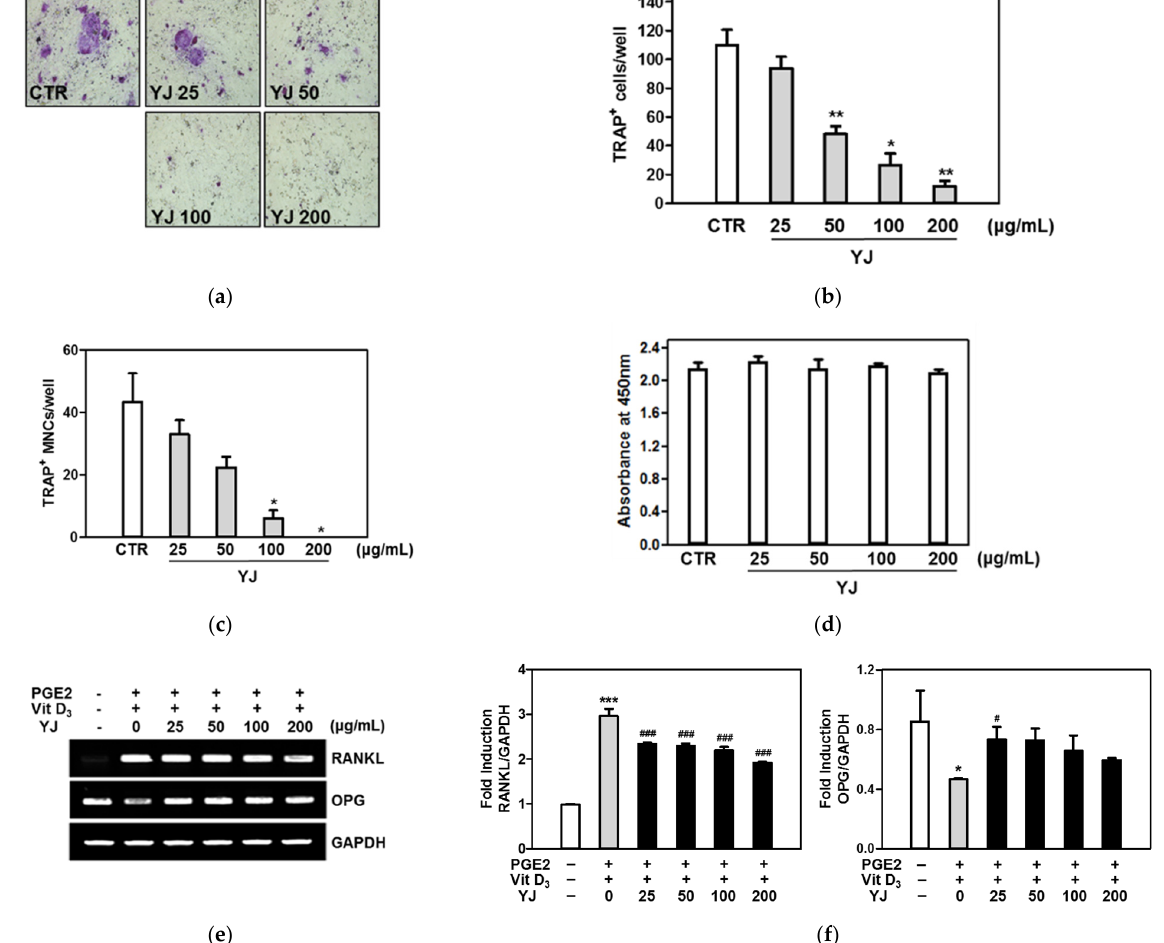
Figure 2. YJ suppressed osteoclastogenesis in the co-culture of bone marrow cells (BMCs) and mouse calvaria-derived osteoblasts. ( a ) BMCs and mouse calvaria-derived osteoblasts were co-cultured for 7 days in a medium containing vit D 3 and PGE2 in the presence of YJ. Cells were fixed, permeabilized, and stained with TRAP solution. Images were captured under a light microscope (100× magnification). ( b , c ) TRAP-positive cells and TRAP-positive MNCs with more than three nuclei were counted. ( d ) Co-cultured cells were seeded into a 96-well plate and cultured for 4 days. After 4 days, cell viability was analyzed using the XTT assay. ( e ) Total RNA was extracted from the cells, and the mRNA levels of OPG, RANKL, and GAPDH (glyceraldehyde 3-phosphate dehydrogenase) were measured using RT-PCR. For RT-PCR analysis, the PCR products were electrophoresed on a 1.5% agarose gel and were visualized by ethidium bromide staining. ( f ) Quantitative real-time RT-PCR was performed to determine the mRNA expression of OPG and RANKL. Data are presented as the mean ± SD of four independent experiments. * p < 0.05, ** p < 0.01 *** p < 0.001 vs. the control group and # p < 0.05, ### p < 0.001 vs. the vitamin D 3 - and PGE2-treated group.